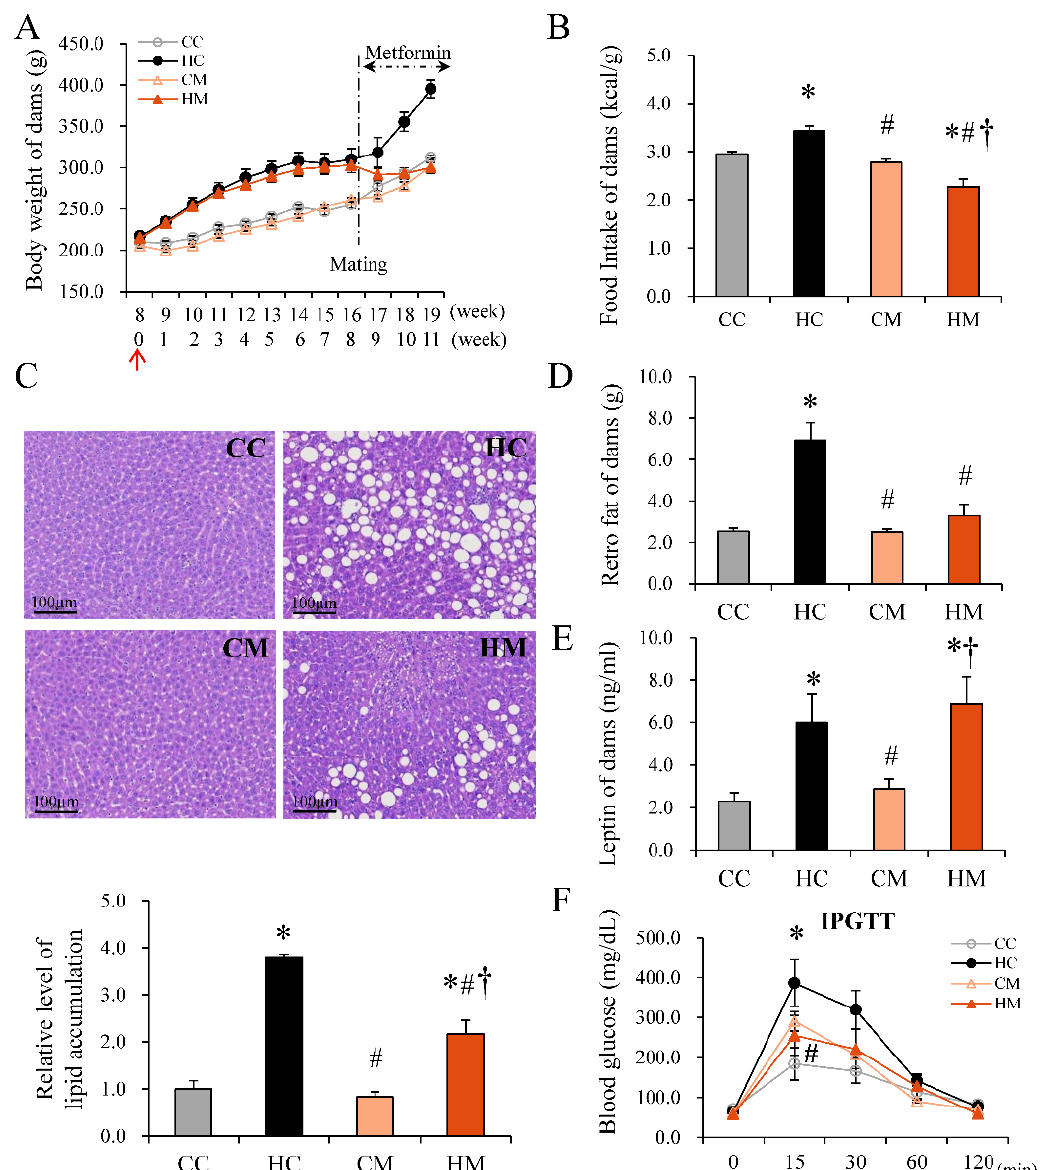
Figure 1. Physiological characteristics of dams fed a control diet (CC), high-fat diet (HC), maternal control diet with maternal metformin treatment after mating (CM), or maternal high-fat diet with maternal metformin treatment after mating (HM). ( A ) Body weight (BW) change. The red arrow indicates the beginning of diet manipulation. The numbers on the upper row represent the age of the dams, and the numbers on the lower row represent the time period of food manipulation. A significant increase in BW was observed after one week of high-fat diet manipulation. Metformin was then administered after mating. A significant decrease in BW was observed after 2 weeks of metformin treatment (#). Detailed BW data are presented in Supplementary Table S2. ( B ) Caloric intake per unit of BW. ( C ) Histological manifestation of liver tissue: The degree of hepatic steatosis is presented as a vacuolation increase via hematoxylin and eosin (H&E) staining. ( D ) Weight of retroperitoneal fat depot. ( E ) Plasma leptin level. ( F ) Data from the intraperitoneal glucose tolerance test (IPGTT). Detailed blood sugar and area under the curve (AUC) data are presented in Supplementary Table S3. The results are presented as the mean ± standard error. * Compared to the CC group, p < 0.05; # compared to the HC group, p < 0.05; † compared to the CM group, p < 0.05.